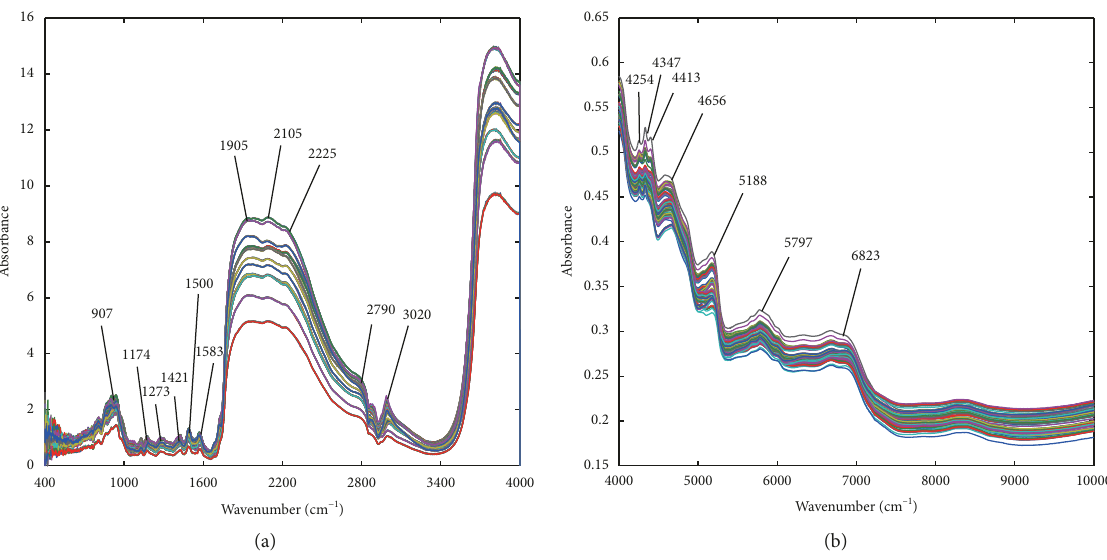
Figure 1: (a) Raw MIR spectra of 12 green tea samples; (b) raw NIR spectra of 12 green tea